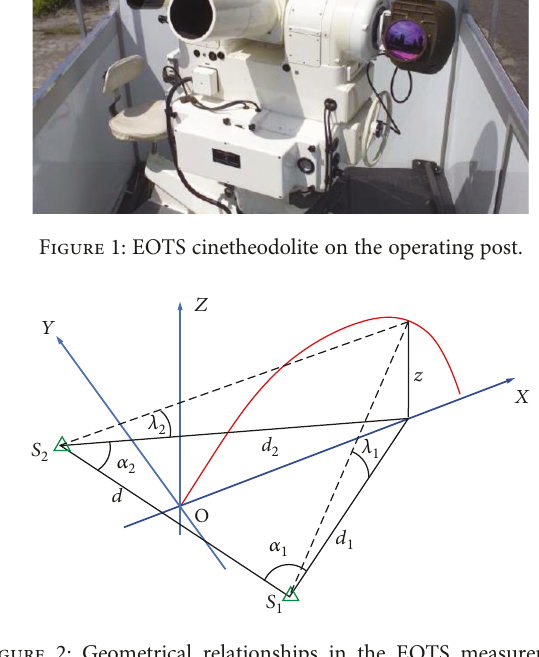
Figure 2: Geometrical relationships in the EOTS measurement system